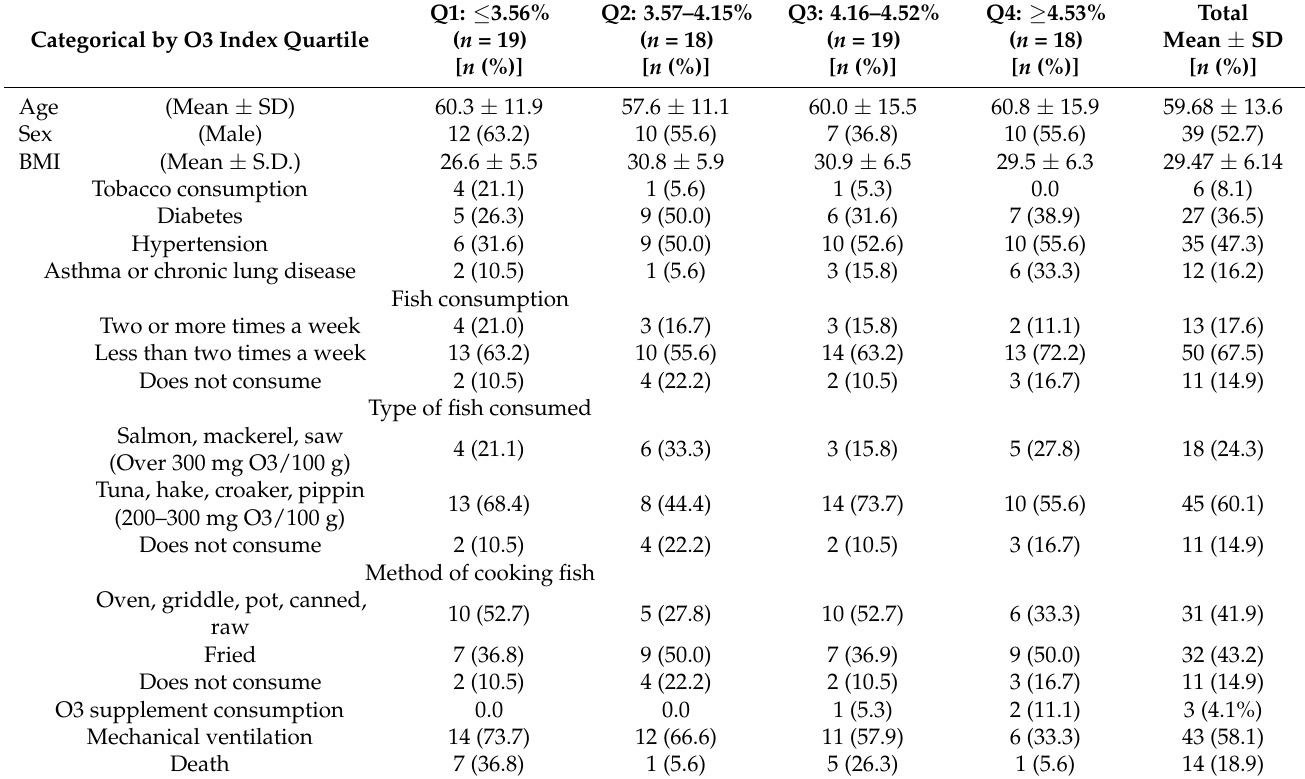
Table 2. Demographic, clinical, and fish consumption profiles of the participants stratified by O3 Index quartiles.